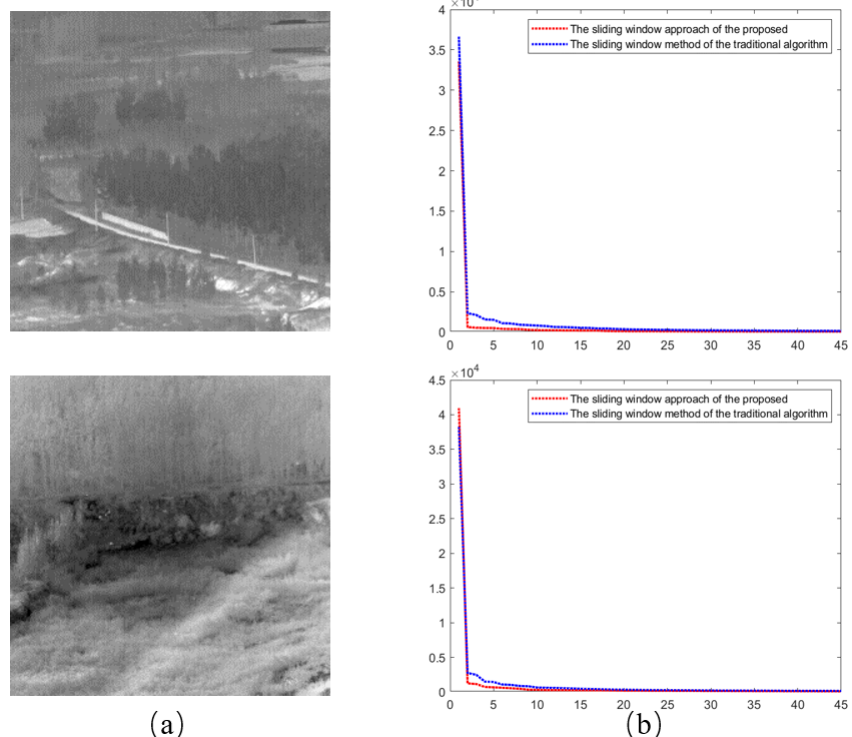
Figure 6. Singular values of different methods for tensor construction. The ( a ) column shows classical complex backgrounds, and on the ( b ) column are the results in descending order of singular values by different methods. The blue line is the classical sliding window sampling method, and the red line is the one proposed in this